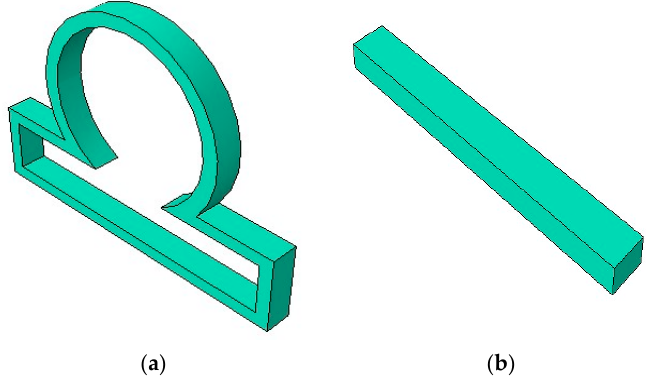
Figure 1. ( a ) An idealized axisymmetric intracranial saccular aneurysm model, ( b ) long rigid contact constraint .